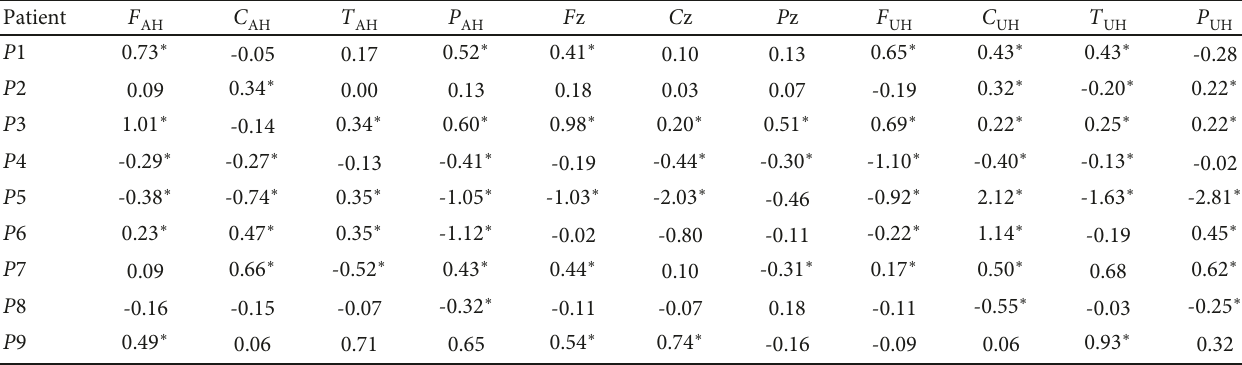
C T P F z , AH , AH , AH , and AH ), sagittal ( fi cant correlation with time